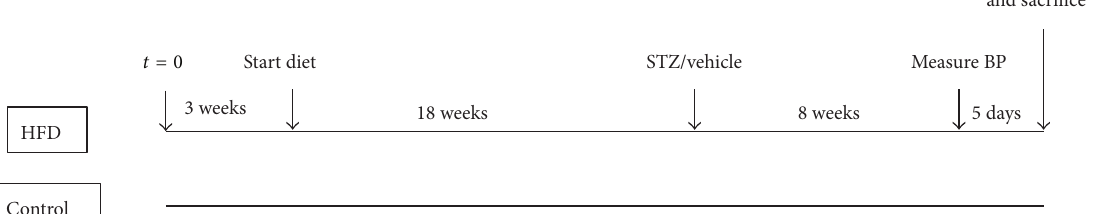
Figure 1: Timeline depicting the initiation of the assigned diet (high-fat or control diet), administration of streptozotocin or vehicle, blood pressure measurement, and tissue harvesting followed by